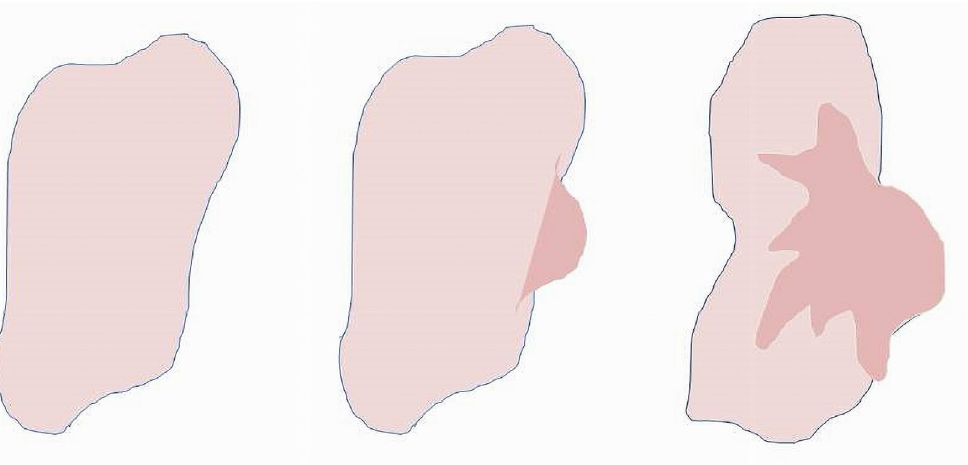
Figure 1. Exaggerated sketch images of normal tissue ( left ) benign tumor ( middle ) and cancer in- vasion ( right ).